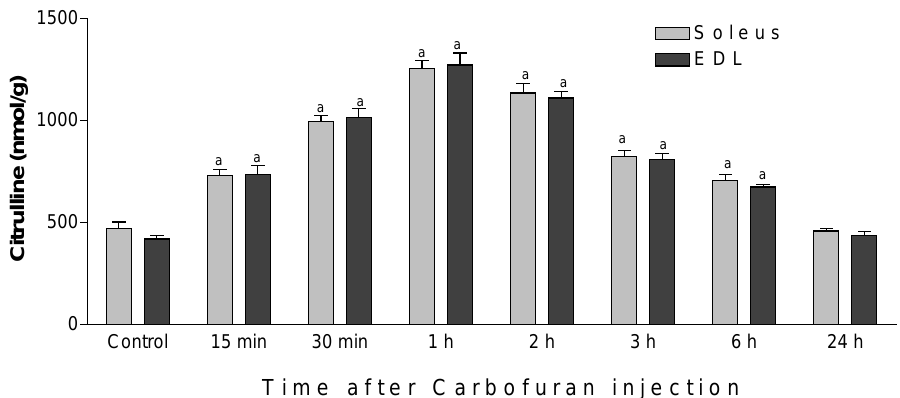
FIGURE 2 . Levels of citrulline in soleus and EDL muscles of rats intoxicated with an acute dose of CF (1.5 mg/kg, s.c.). Values of citrulline are presented as mean ± SEM (n = 4–6). a Significant difference between control and CF-treated rats ( p <